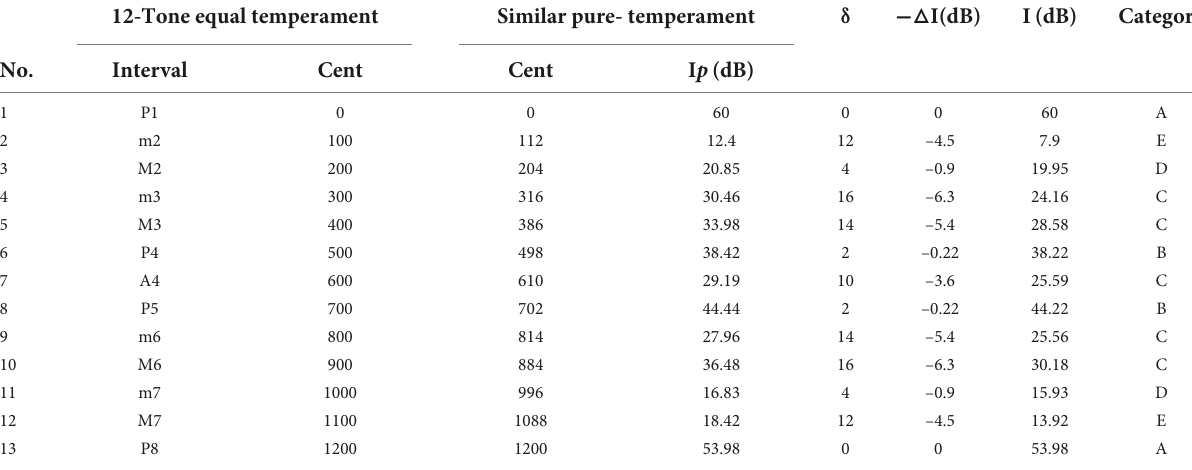
TABLE 4 The interval consonance index of each interval of the 12-tone equal temperament ( Q =